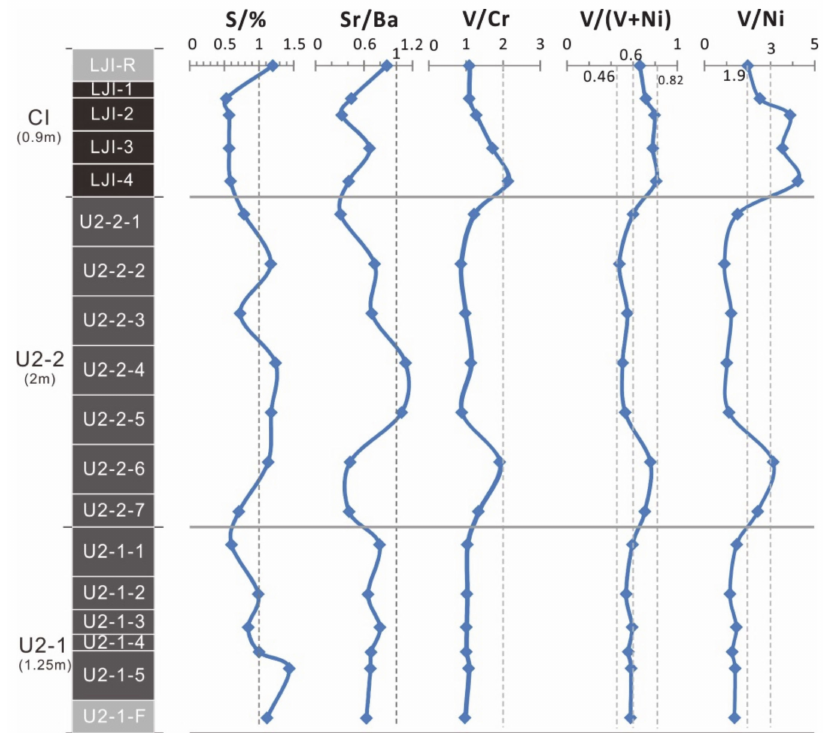
Figure 12. Variations in geochemical indicators for the marine influence on the lacustrine environment of the section of the C1 coal seam and OS2 oil shale seam in the Liangjia Coal Mine. The horizontal grey lines separate the C1, the upper part, and the lower part of OS2. The vertical dashed lines are the specific value of each